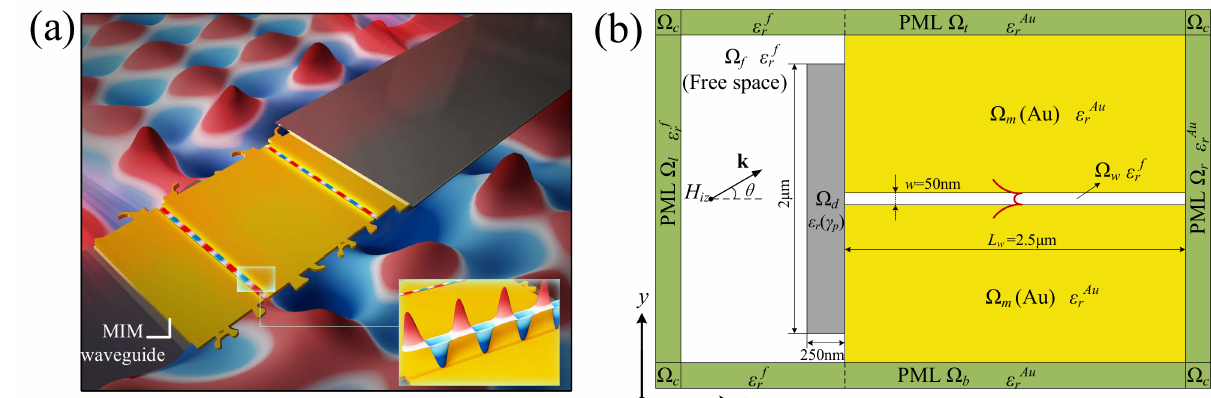
Figure 1. ( a ) The nanoantennas, which were inversely designed by using topology optimization, can couple the free space and MIM waveguide and efficiently excite the MIM plasmon modes at multiple wavelengths and under the oblique incidence. ( b ) Sketch of the 2D model of MIM waveguide. The model consists of a domain of free space Ω f corresponding to the plane wave of the upper left part and the lower right part in Figure 1a, the sandwiched MIM waveguide composed of two Au domains Ω m , and a free space domain Ω w corresponds to the middle gold part in Figure 1a. The design domain Ω d for the nanoantennas is localized at the left endface of the MIM waveguide corresponds to both endfaces of the middle gold part in Figure 1a. The domain Ω = Ω f ∪ Ω d ∪ Ω m ∪ Ω w is enclosed by perfectly matched layers (PMLs) Ω = Ω t ∪ Ω ∪ Ω ∪ Ω r ∪ Ω c . The width and length of the MIM waveguide are the typical sizes of w = 50 nm and P b l L w = 2.5 µ m, respectively, which correspond to the part which filled with MIM plasmon modes in Figure 1a. These sizes can be fabricated by the processes introduced in [26,27]. The thickness and width of the design domain are 250 nm and 2 µ m, respectively. H iz is the incident wave. θ is the oblique angle, which is the angle between the wave vector κ and positive x